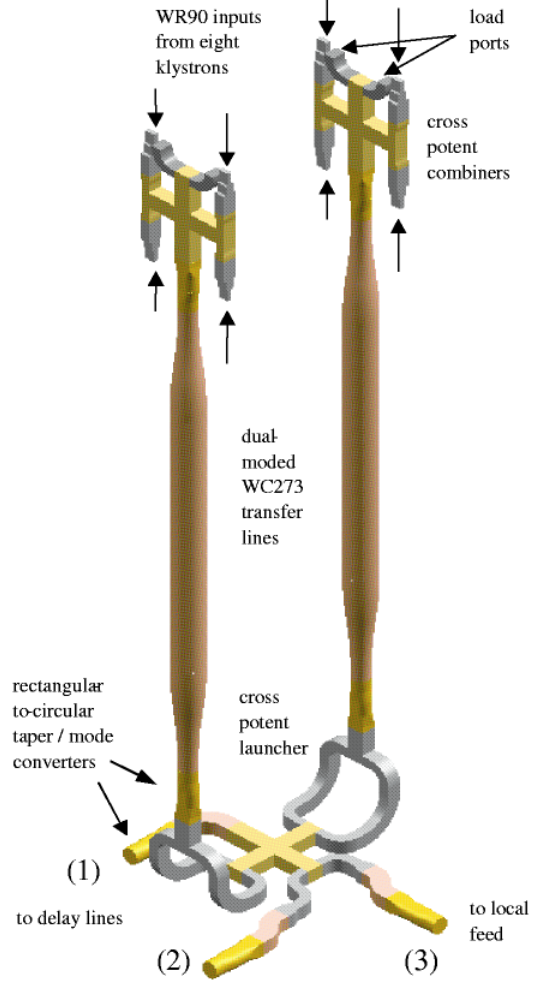
FIG. 8. (Color) The 8 3 4 combiner/launcher waveguide circuit for a DLDS